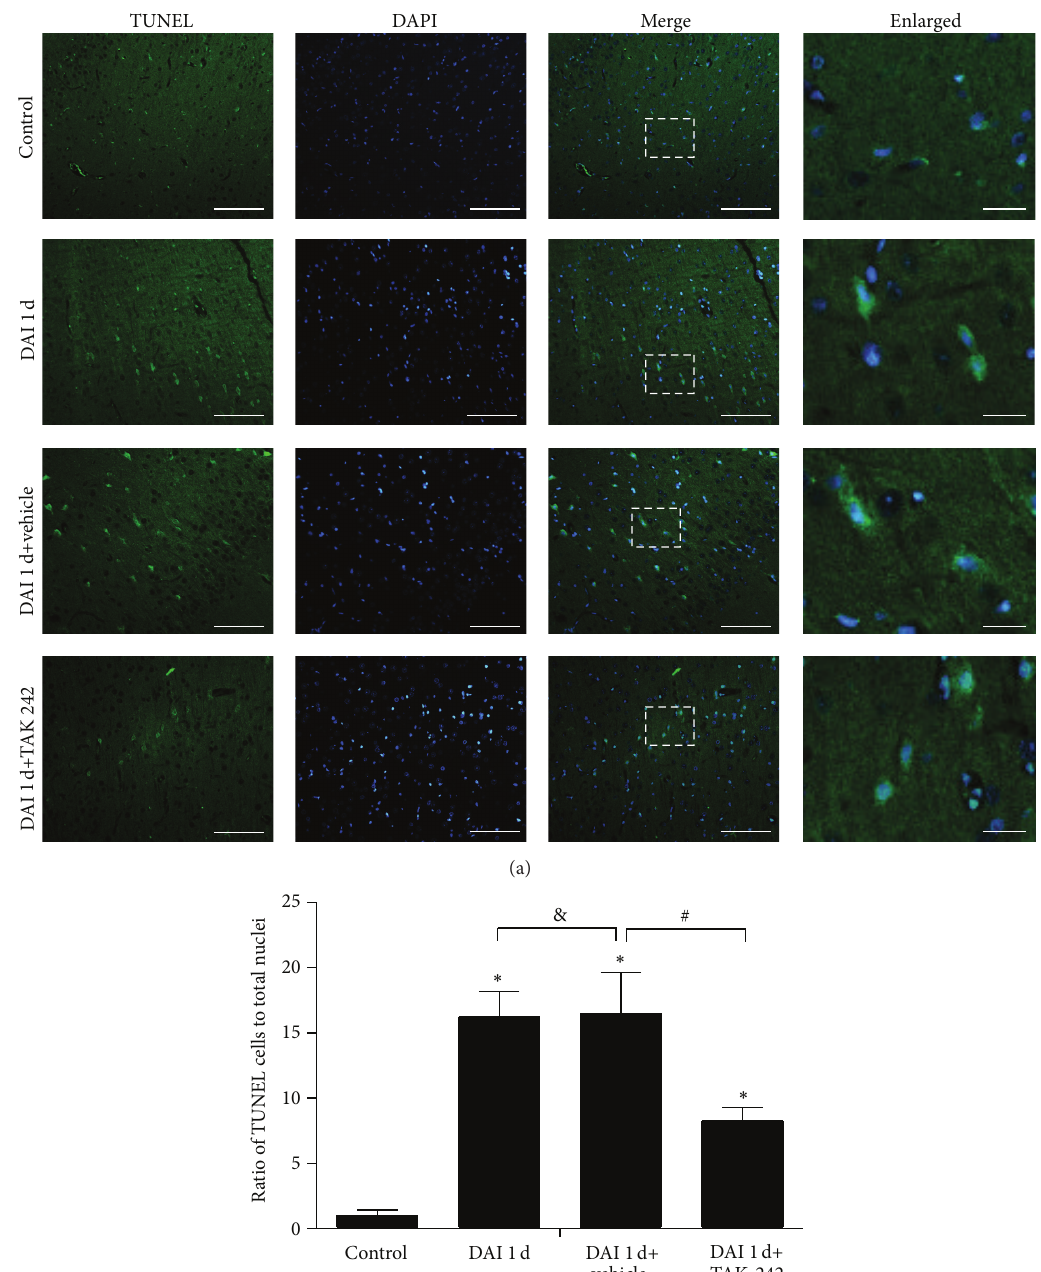
Figure 5: TLR4 inhibition significantly attenuated apoptosis after DAI. (a) TUNEL assay was used to detect apoptotic cells in the cortices of rats in the control, DAI 1d, DAI 1d+vehicle, and DAI 1d+TAK-242 groups. TUNEL-positive cells were stained green, and the nuclei were stained with DAPI (blue). Scale bar = 100 𝜇 m; enlarged figure scale bar = 20 𝜇 m. (b) The bar graphs show the results regarding the numbers of apoptosis cells, which are expressed as the ratio of TUNEL to total nuclei. Positive cell levels were counted in 5 random cortical fields (40x magnification). Data are presented as the mean ± SD ( 𝑛 = 6 ; ∗ 𝑝 < 0.05 , compared with control group; # 𝑝 < 0.05 , & 𝑝 > 0.05 , compared with DAI 1d+vehicle